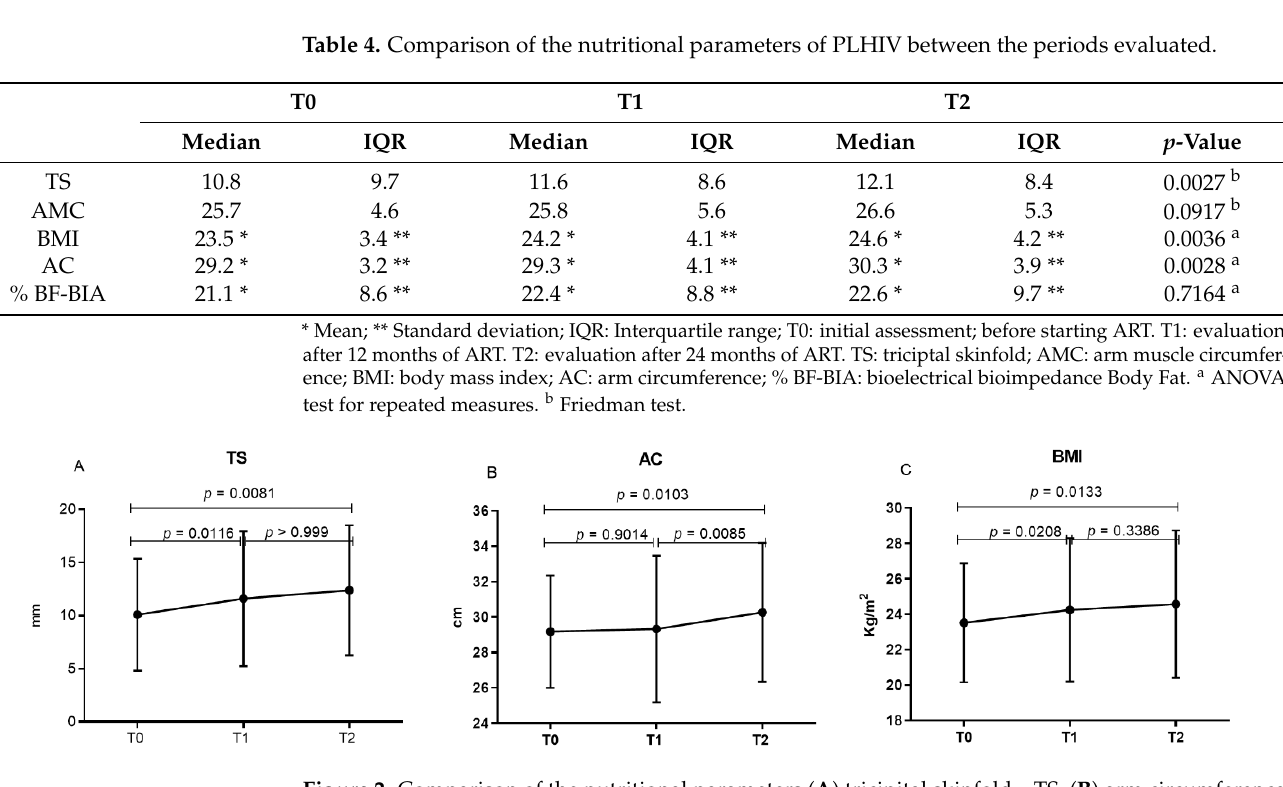
Table 4. Comparison of the nutritional parameters of PLHIV between the periods evaluated.